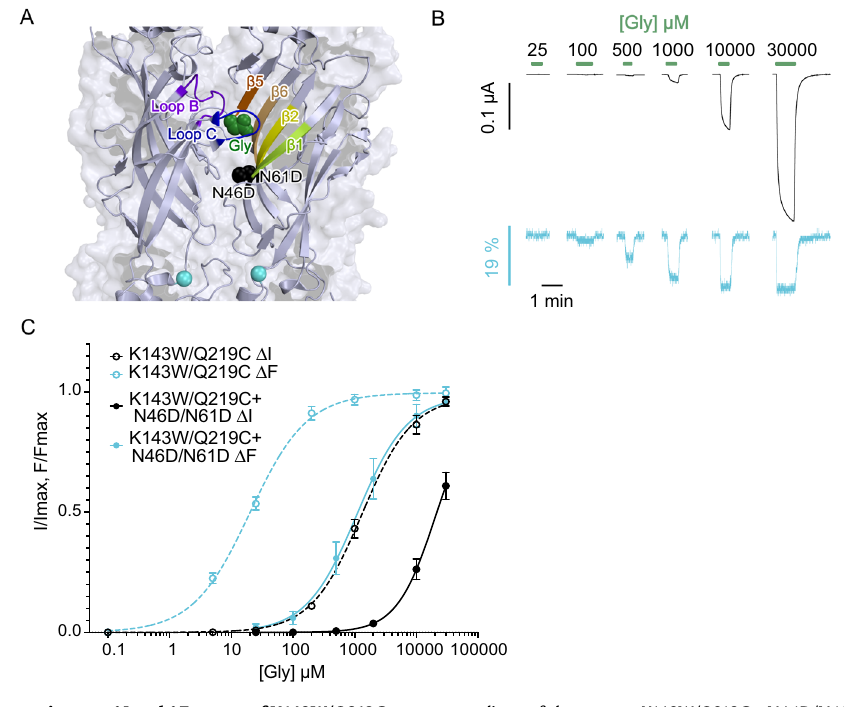
recordings of the mutant K143W/Q219C+N46D/N61D (current in black and fl uor- escenceincyan). C Δ I(cyan)and Δ F(black)dose-responsecurveswithmean±SEM show a parallel shift of the current and fl uorescence curves of the K143W/Q219C/ N46D/N64D mutant (solid line; n =5) compared to K143W/Q219C alone (dotted